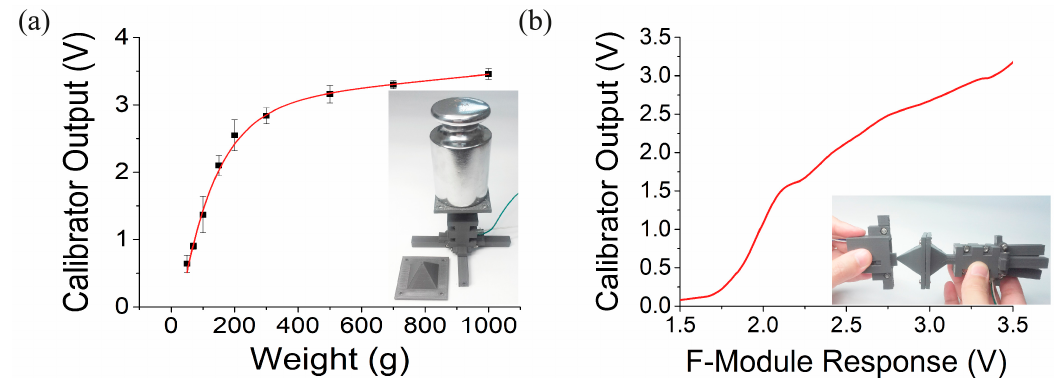
Figure 4. F-module sensor calibration. ( a ) Weight dependent output of the calibration tool. Its transposed curve was fit to a polynomial equation. (See Supplementary Materials.) Inset shows a picture of the measurement process. ( b ) Calibration of the f-module output voltage. The curve was fit to a polynomial equation in the Supplementary Materials. The bias of the f-module response came from the pre-load of the spring in the f-module. Inset shows a picture showing the application of force to the f-module by the calibration tool using the pyramidal tip in ( a ).